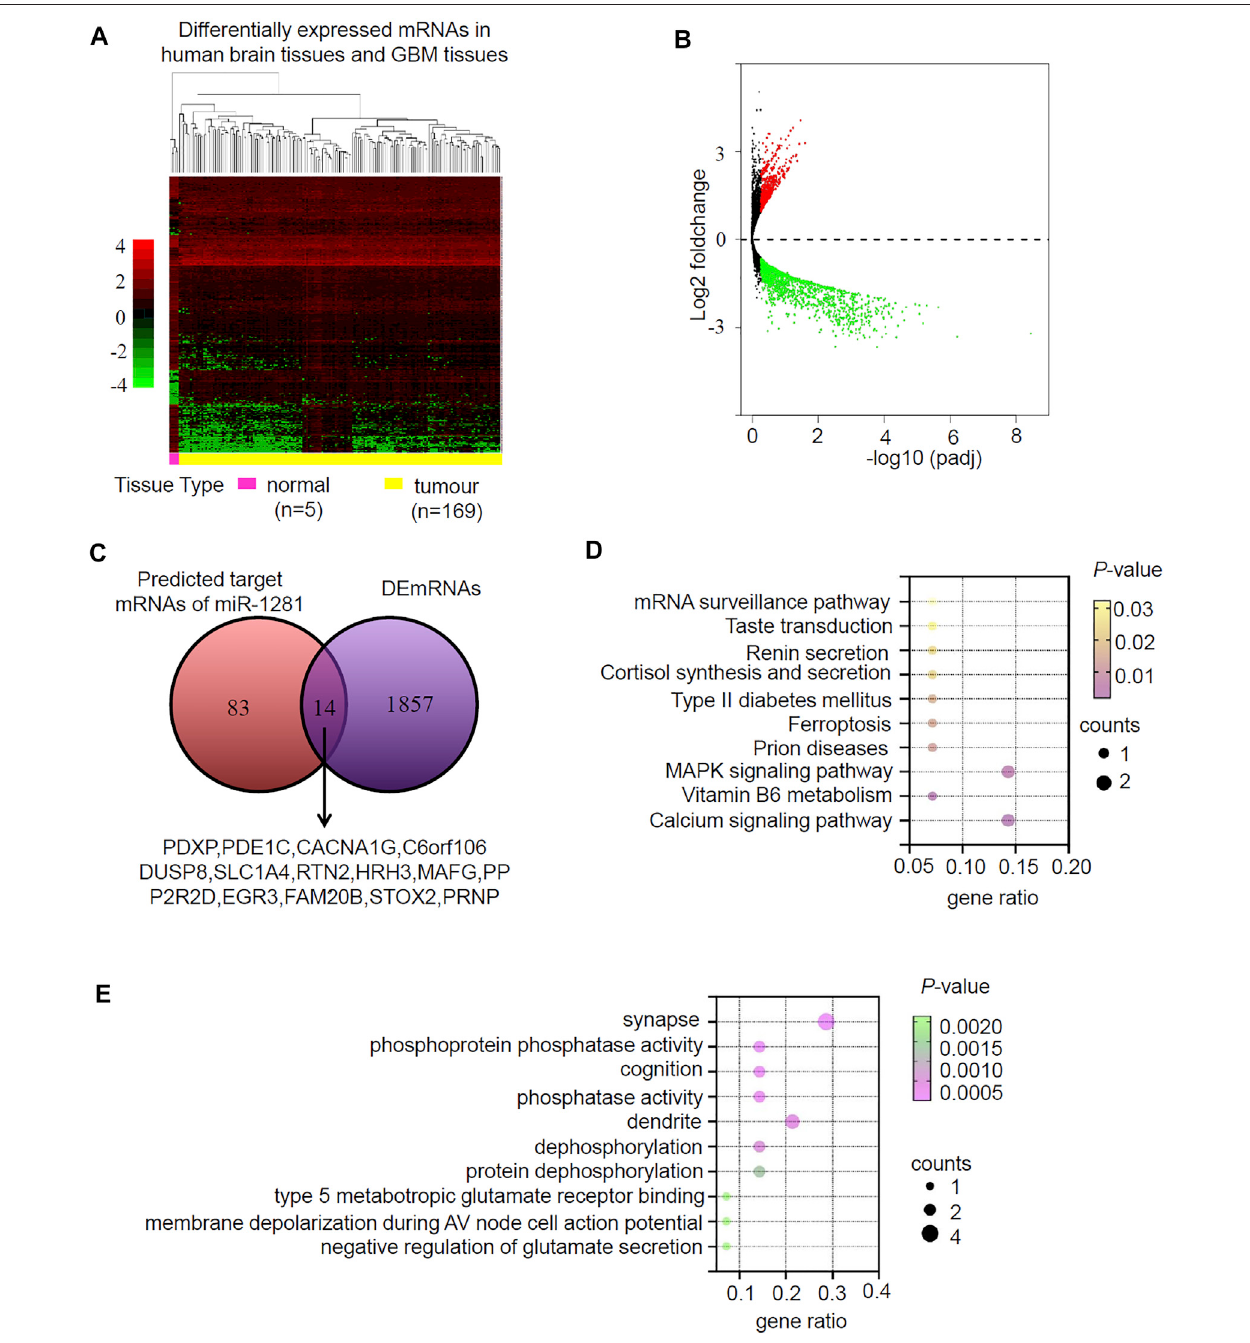
FIGURE 5 | Prediction and analysis for Target genes of miRNA in GBM. (A) Clustered heatmap showing differentially expressed mRNAs (DEmRNAs) in human normal brain and GBM tissues. The color scale indicates the foldchange of the log2 value of the reads for each gene in tumors vs. normal tissues (red represents up- regulation; blue represents down-regulation). (B) Volcano plot of deferentially expressed miRNAs in human normal brain and GBM tissues. The red dots represent upregulatedmiRNAsandbluedotsrepresent downregulatedmiRNAswithstatisticalsigni fi cance(|log2FC > 1and p -value < 0.05). (C) Intersection ofthepredicted target mRNAs of miR-1281 and DEmRNAs. (D) The KEGG pathways in which the potential miR-1281 target mRNAs were enriched. (E) The GO analysis revealing the biological functions in which the potential miR-1281 target mRNAs were enriched.